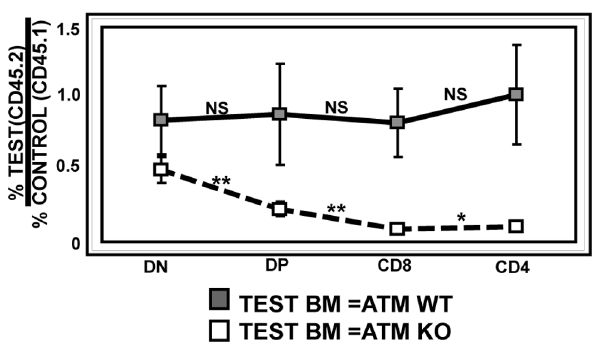
Figure 5. Competitive chimeras demonstrate that the ATMKO defect in DN to DP development is T cell-intrinsic. This graph shows the ratio of thymocytes derived from test (ATMWT or KO CD45.2 + ) and control (ATMWT CD45.1 + ) bone marrow for each thymic subset. When both test (CD45.2 + ) and control (CD45.1 + ) bone marrows are ATMWT (solid black line), the ratio of test/control cells is not significantly changed during thymic development. In contrast, when test bone marrow is ATMKO (CD45.2 + ) (dashed black line) the ratio of test/control (ATMKO/ATMWT) cells decreases as thymocytes develop from DN to DP cells (p , 0.007) and from DP to CD8 (p , 0.005) or CD4 (p , 0.02) SP cells. Data from two independent sets of chimeras consisting of 16–20 mice in each group were combined for this analysis. P values were calculated using Student’s unpaired 1-tailed t-